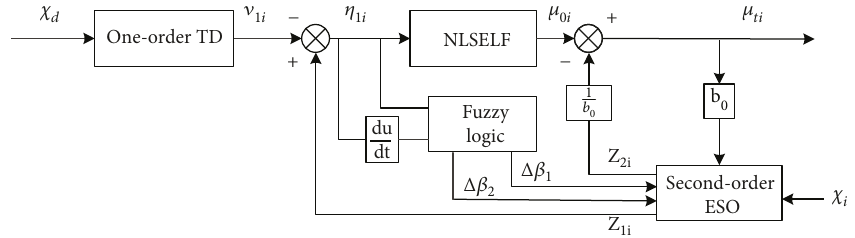
Figure 5: Schematic diagram of